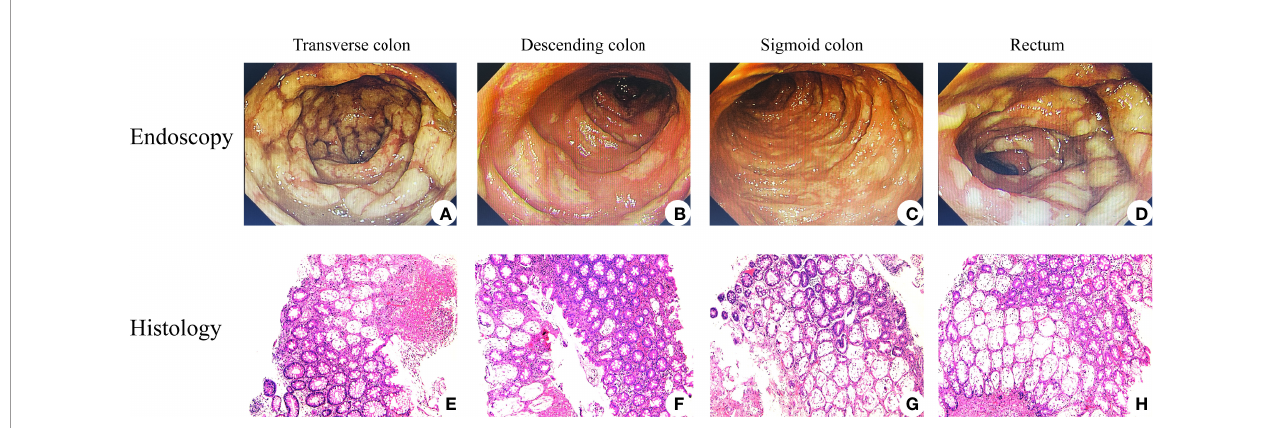
FIGURE 2 | Endoscopic and histological features of immune checkpoint inhibitor (ICI)-related colitis. Endoscopic images of colons revealed that mucosal congestion, edema, rough, unclear perivascular texture, multiple super fi cial ulcers with purulent secretions, and white moss existed among transverse colon (A) , descending colon (B) , sigmoid colon (C) , and rectum (D) . H&E staining performed is shown in panels (E – H) , all with magni fi cation of ×100. Histology images courtesy of Qiongyi